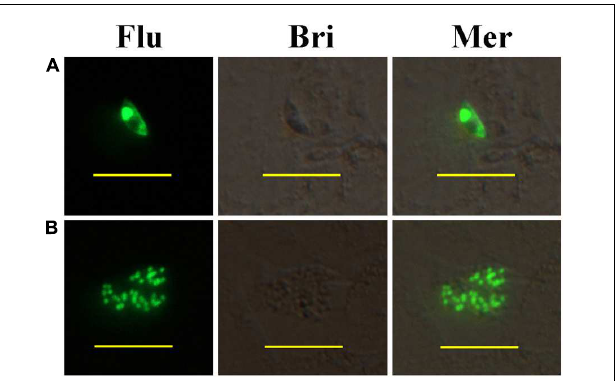
FIGURE 1 | Development of transiently transfected Eimeria intestinalis sporozoites in primary rabbit intestinal cells (PRICs). (A) A sporozoite expressing YFP in PRICs; (B) a first generation schizont expressing YFP in PRICs. Flu, Bri, and Mer indicate fluorescent field, bright field, and merged images, respectively. Bar = 20 µ